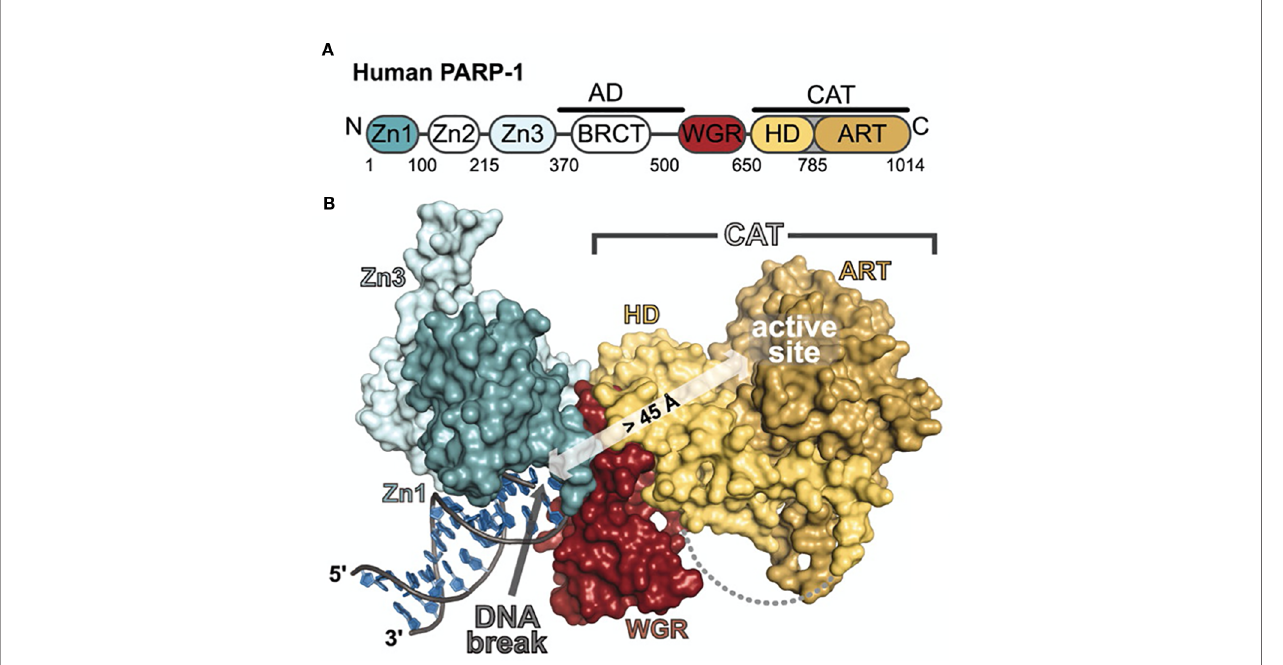
FIGURE 1 | Schematic representation and crystal structure of PARP1 domains and subdomains. (A) Schematic representation of human PARP-1 domains and subdomains. A BRCA C-terminus (BRCT) fold is located within the region of PARP-1 that is primarily targeted for automodi fi cation. The catalytic domain is composed of an alphahelical subdomain (HD) and an ADP-ribosyl transferase subdomain (ART). (B) Crystal structure of the PARP-1/DNA structure. Zn1, Zn3, and WGR-CAT are shown as surfaces. The arrow indicates the location of the PARP-1 automodi fi cation region near the catalytic active site. From Langelier et al., 2012. Reprinted with permission from AAAS. [PDB code 4DQY, (Langelier et al.,